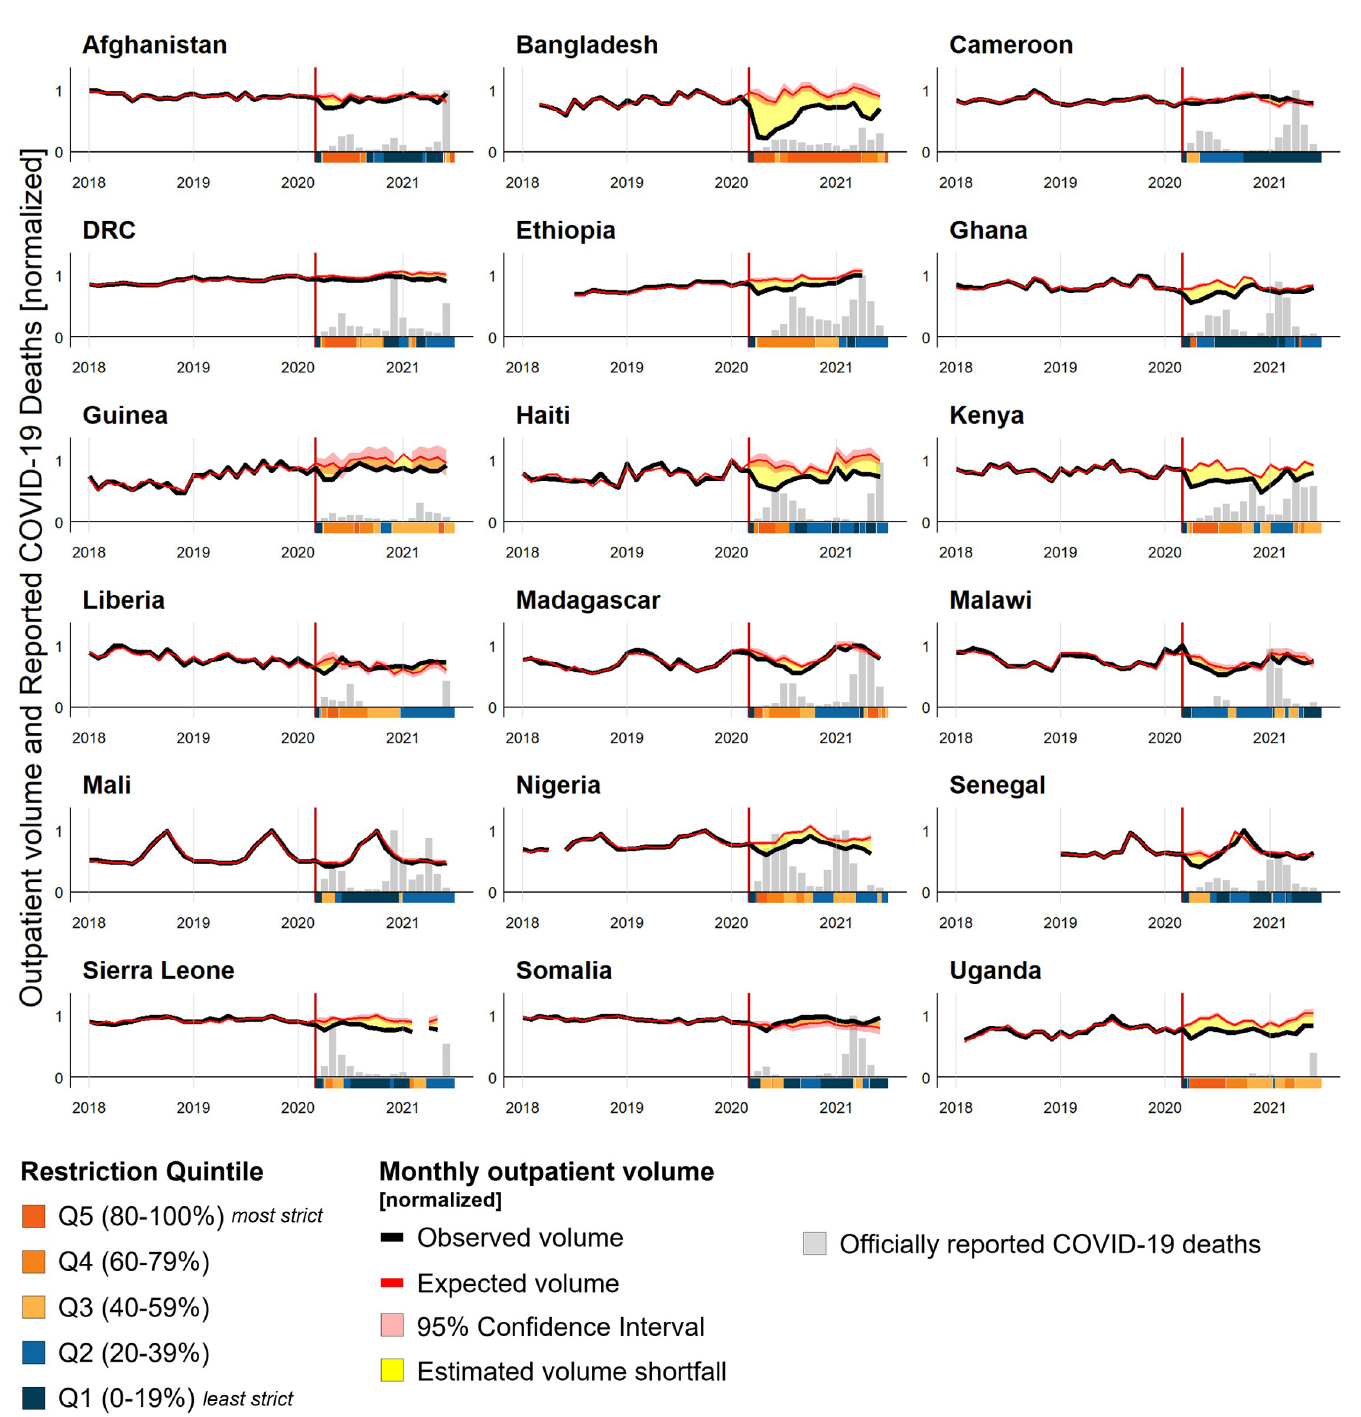
Fig 2. Estimated and observed volume of outpatient consultations with officially reported COVID-19 deaths per 100,000 and mobility restrictions by country, January 2018–June 2021. Note: Outpatientconsultations are used as a proxy for the utilization of general health services. Data on officially reported COVID-19 deaths are compiled from Johns Hopkins University Coronavirus dashboard [1].Population denominators for all countries are based on 2019 estimates from the World Bank Development Indicators database. Utilization volume and mortality data are normalized across countries by dividing by the highest observed monthly value within each country. Data on mobility restrictions is summarized by an index of public transport closures, stay-at-home requirements, movement limitations, school closures, and workplace closures stringency scores provided by the Oxford COVID-19 Government Response Tracker.The scores from this index are normalized, and the categorized into quintiles. Gaps in the service volume data are due to months removed because of low completeness. Details on indicator reporting can be found in Table L in S1 Text and data completeness can be found in Fig A in S1 Text.DRC is Democratic Republic of the Congo. Results for ANC1, delivery, BCG, and Penta3 are visualized in Fig B in S1 Text.